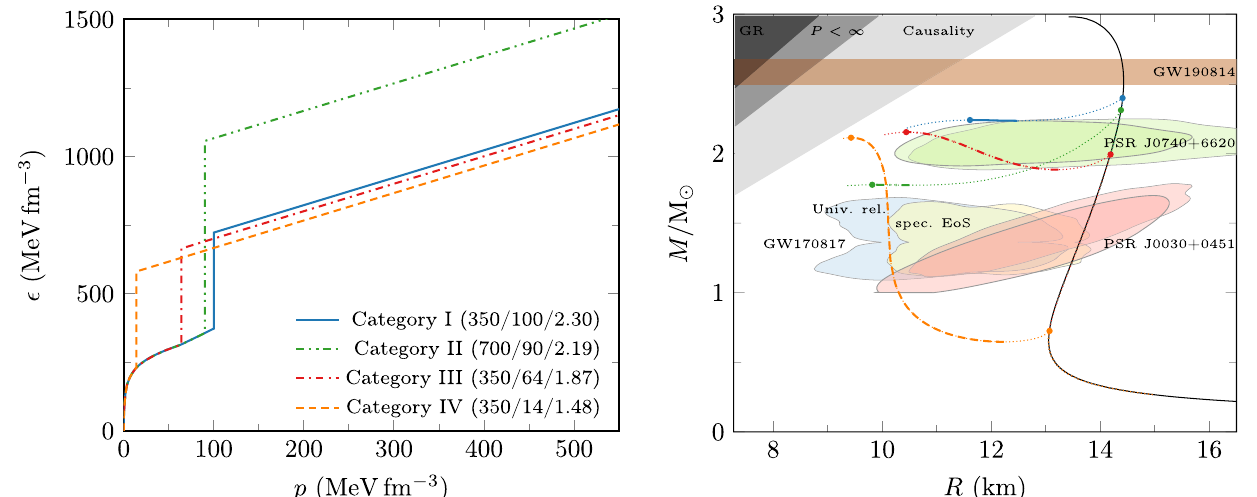
Fig. 1 Leftpanel: The EoS for the CSS model considering distinctval- ues of (cid:8)(cid:3) , p t (both in units of MeVfm − 3 ) and the transitional baryon number density (in units of n 0 ), which generate twin stars in the four categories defined in Ref. [12]. Right panel: Corresponding predictions for the mass–radius relation of a neutral compact star. For comparison, the pure hadronic case (black thin curve) obtained from the Hebeler et al. stiffest EoS [39] is presented. The maximum hadronic and hybrid masses are marked by filled circles. We also present the mass–radius